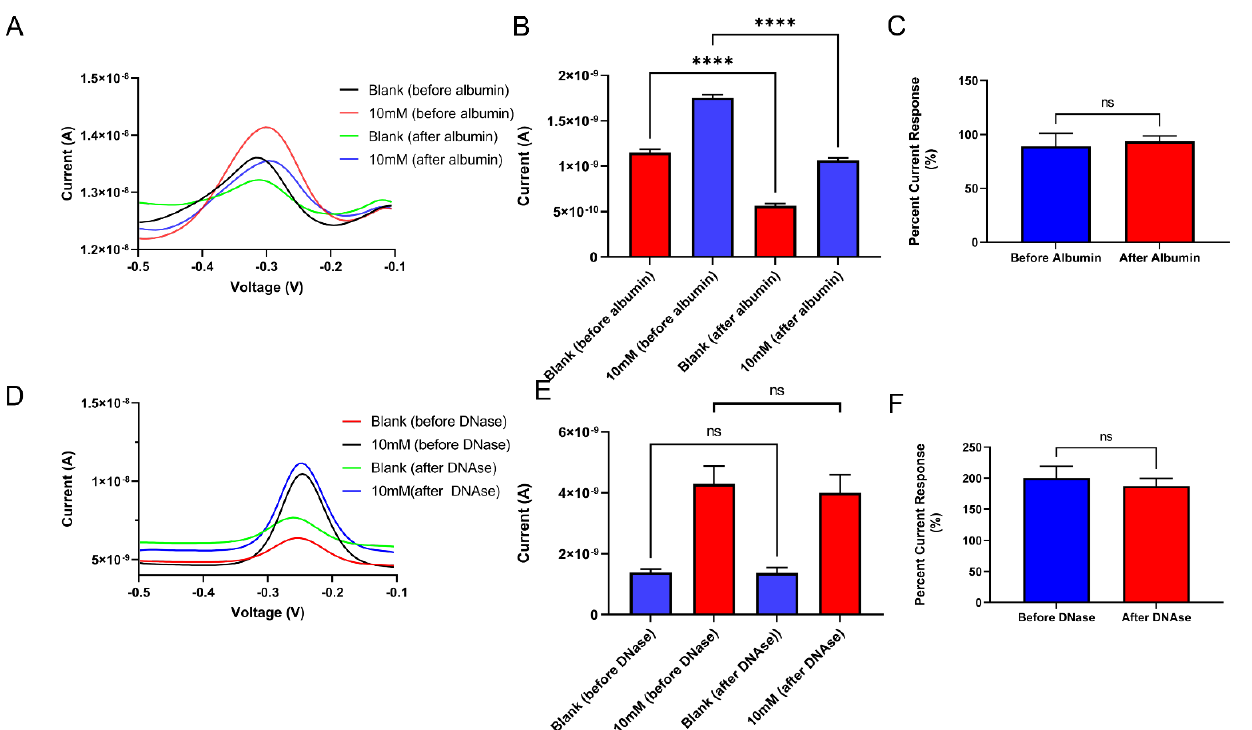
Figure 5. The effects of albumin adsorption and DNase-1 treatment on sensors with PSB coating in vitro. ( A ) SWV waveform of PSB coated sensors before and after albumin exposure. Fluctuations in background current and peak size changes were observed. ( B ) Quantified peak current comparison. Sensors showed significantly decreased current amplitude for both blank and 10 mM cocaine solution after exposure to albumin. One-way ANOVA, n = 25. ( C ) Percent current response quantification. PSB coated sensors showed no change in sensitivity towards cocaine after albumin exposure. Welch’s t test, n = 25. ( D ) SWV waveform of PSB coated sensors before and after DNase-1 exposure. An increase in background current was observed. ( E , F ) Quantified peak current and percent current response comparison. PSB coated sensors showed no signs of degradation after DNase exposure. Current amplitude (One-way ANOVA, n = 8) ( E ) and percent current response (Welch’s t test, n = 8) ( F ) were stable after exposure to DNase. **** p < 0.0001. all data mean + SEM. ( A , D ) SEM removed for visual clarity.